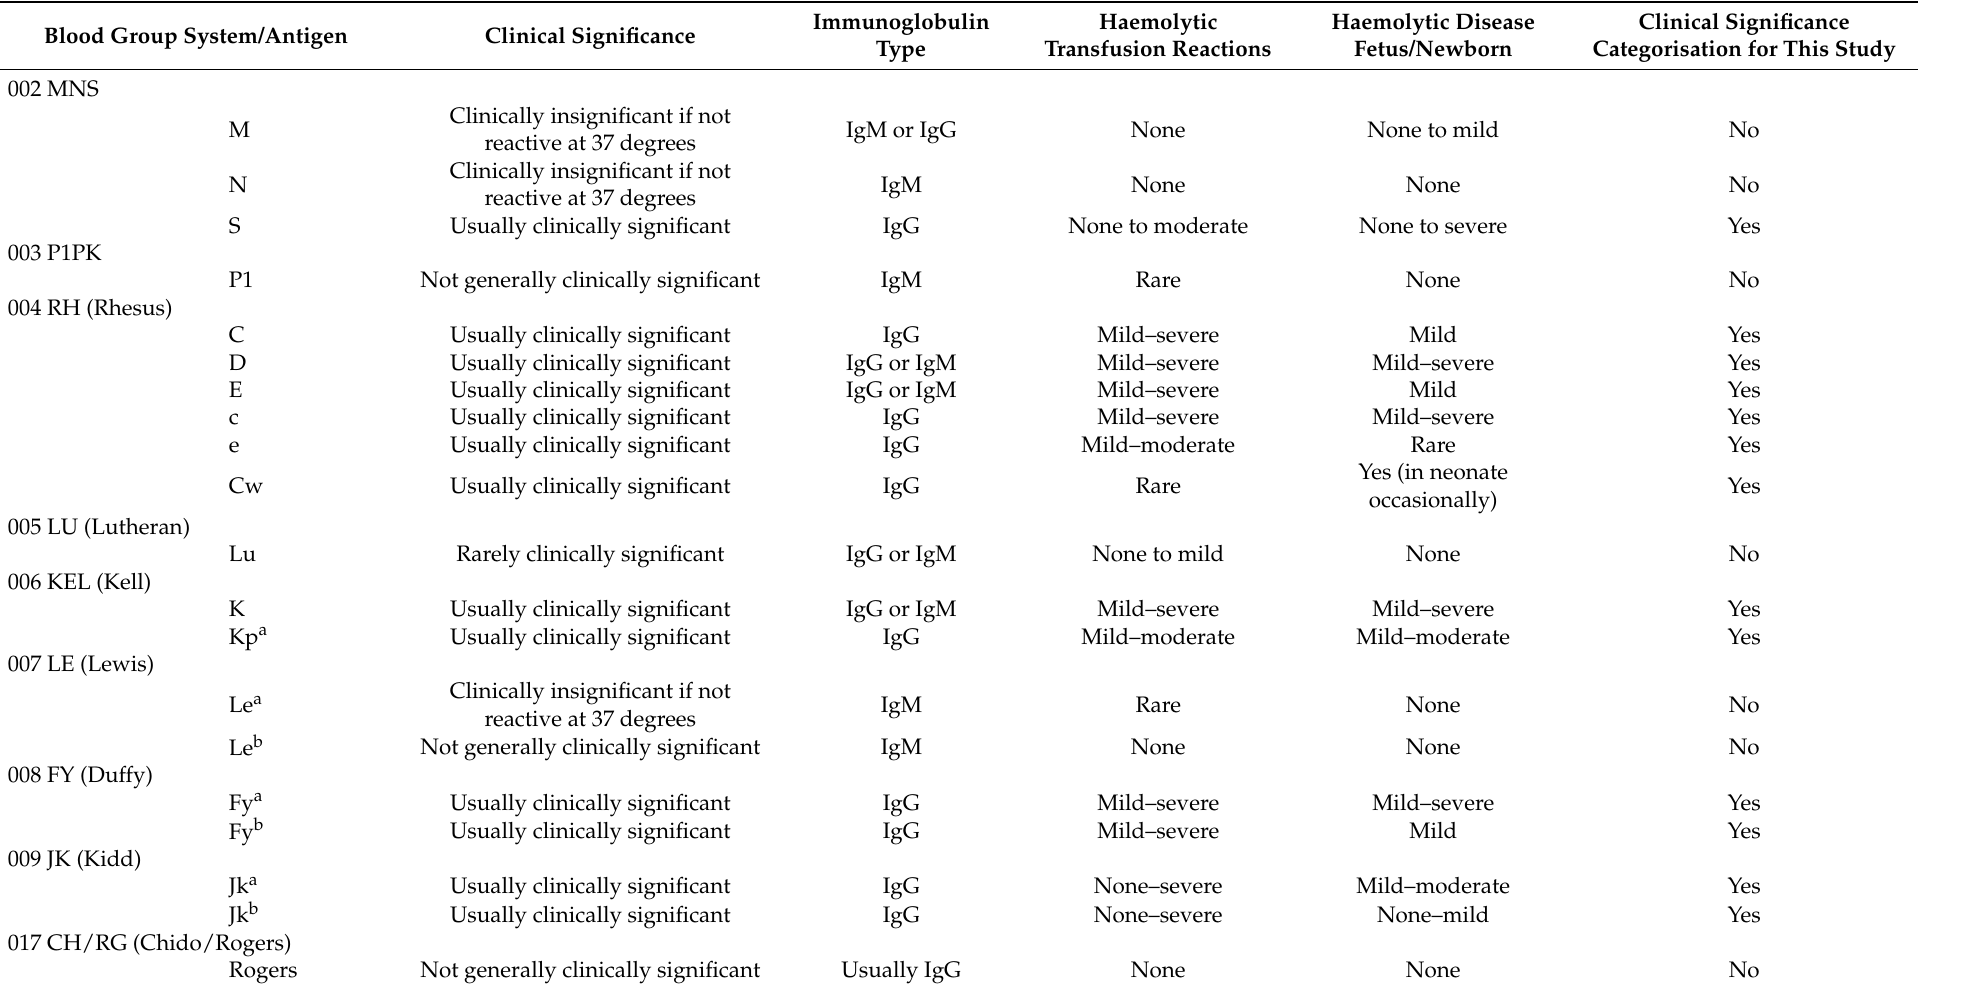
Table 1. Red cell alloantibodies and their clinical significance. Derived from